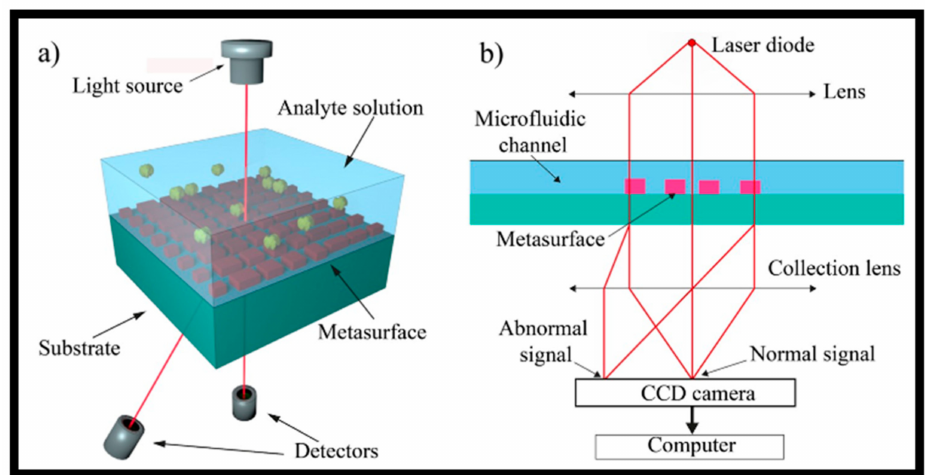
Figure 10. (a ) The design of sensor-based on gradient metasurface (MS). Reprinted with permission from ref. [172]; ( b ) possible optical sensing scheme. Reprinted with permission from ref.